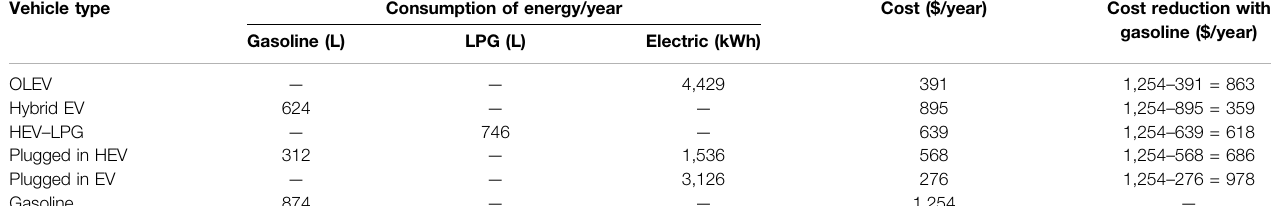
TABLE 12 | Cost of energy consumed by vehicles (operational distance of the vehicle 13,286 km/yr) (Suh et al., 2011). Vehicle type